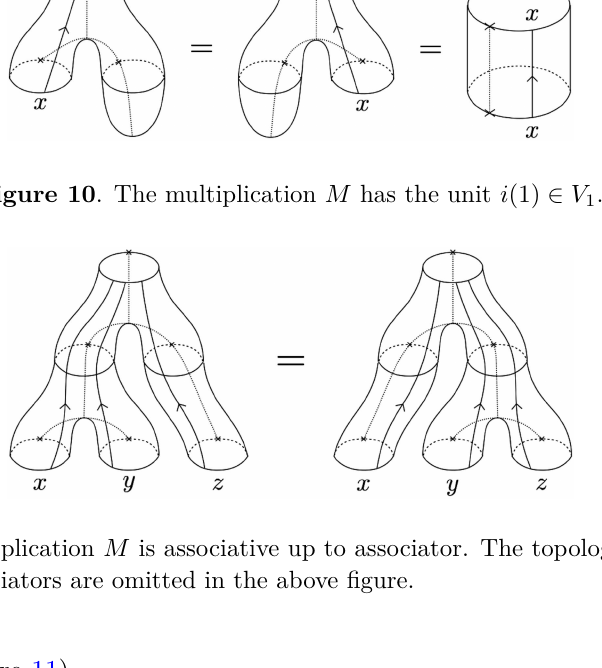
as the dual vector space of V x ∗